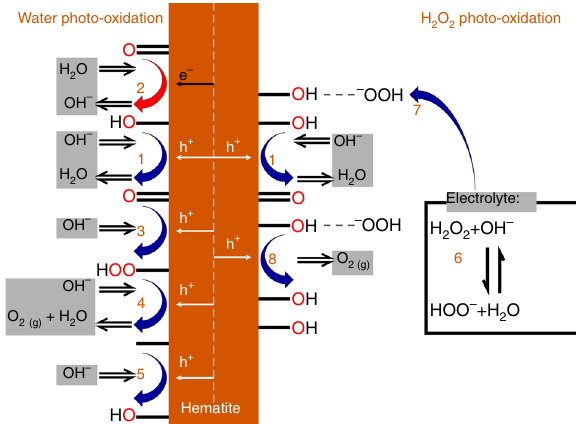
Fig. 3 Schematic illustration of water (left) and H 2 O 2 (right) photo- oxidation reaction paths in alkaline solution. The former follows steps (1) to (5), whereas the latter follows steps (6) to (8) combined with step (1). In addition, the red arrow denotes the recombination reaction (2)